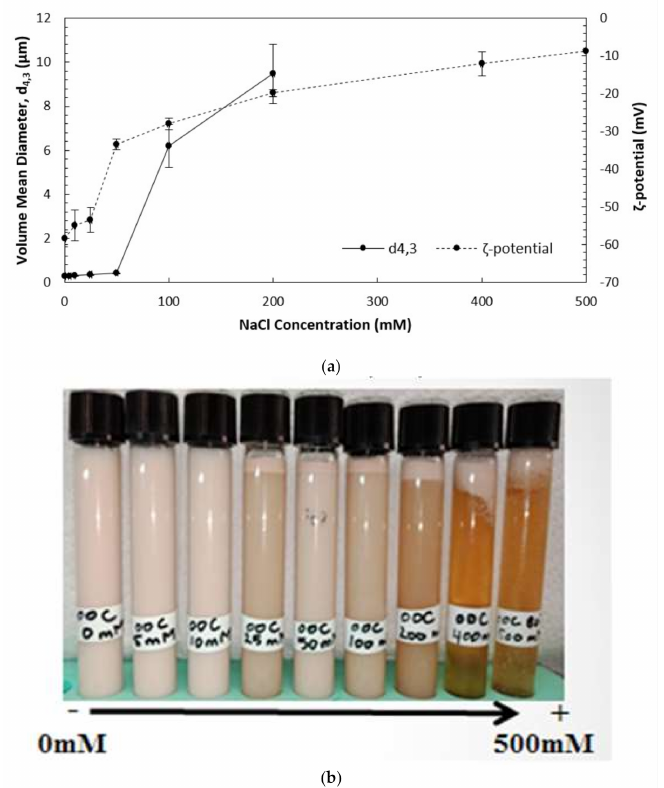
Figure 7. ( a ) Effect of NaCl concentration on the volume mean droplet diameter ( d 4,3 ), ζ -potential and ( b ) visual appearance of O/W emulsions prepared using OOC 80% aqueous ethanolic